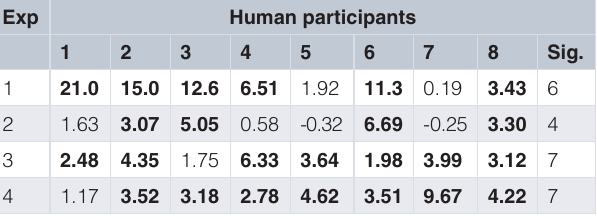
Figure 5. Experimental results of human participants. The initial direction measurement of the movement observed on screen. This is the trial by trial average of all ten subjects. The error bars mark the standard deviation amongst the subjects and the dotted grey line represents the desired target angle observed on screen. The vertical axis is the initial direction measured in degrees and the horizontal axis is the trial number. A . Experiment 1, same task different environment. B . Experiment 2, different task same environment. C . Experiment 3, different task different environment. D . Experiment 4, different task different environment (same display target). E . Group mean of the last trial in state A (baseline) compared to the first trial in state C (aftereffects) in a bar graph. Asterisks indicate statistical significant difference between groups (p < 0.05). Table 2. Statistics of the aftereffect in the 90 degrees rotation experiment. Represented in the table are the aftereffect z scores calculated for each participant for the 4 experiments (Exp). The bolded numbers are the ones considered significant under the assumption of α =0.05 ( | z | > 1.96). The significant column (Sig.) in the table represents the number of z scores (out of 8) that are significant in that